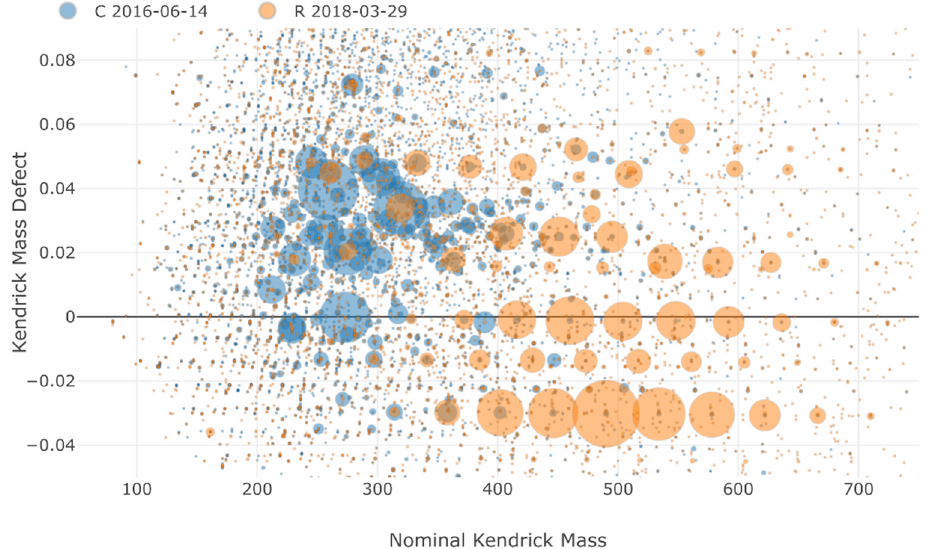
Figure 5. Kendrick mass defect plot for samples from C site (2016-06-14) and R site (2018-03-29), showing characteristic series of homologous compounds at the R site. The size of bubbles is proportional to the intensity of the features.